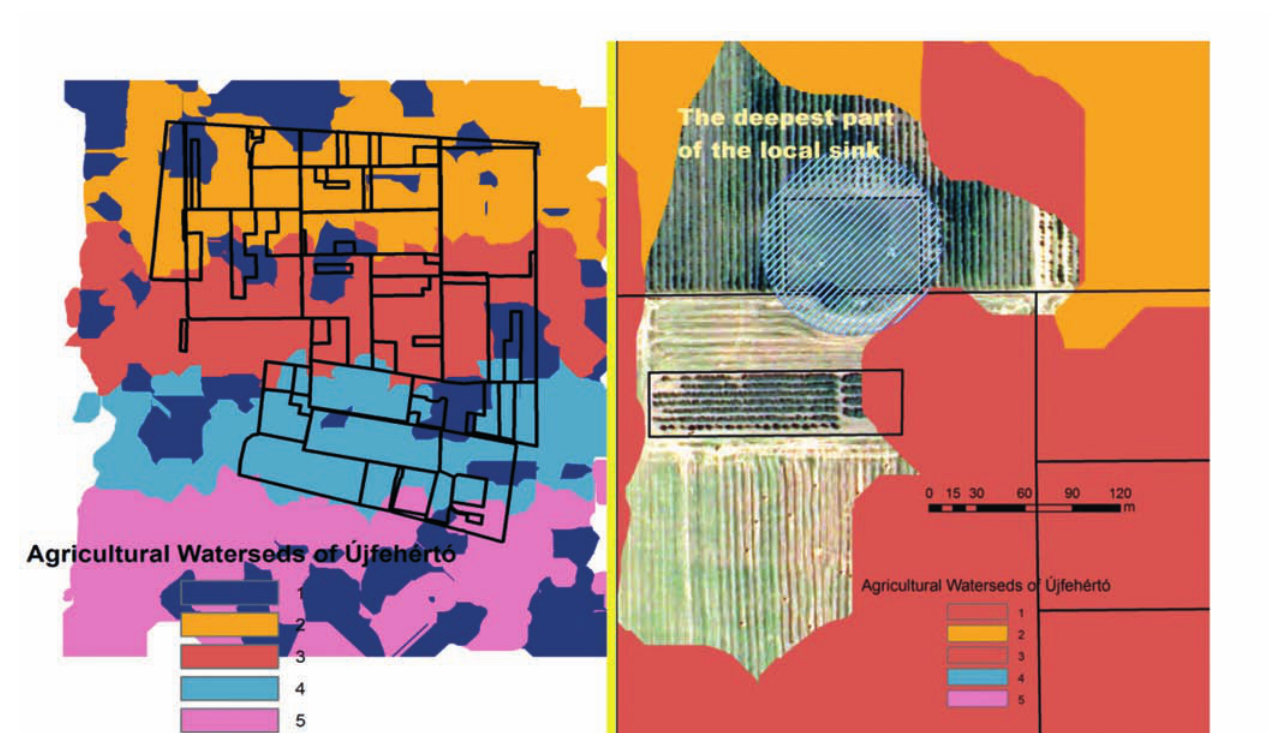
Figure 6. The flow direction and length in the investigation area at Újfehértó